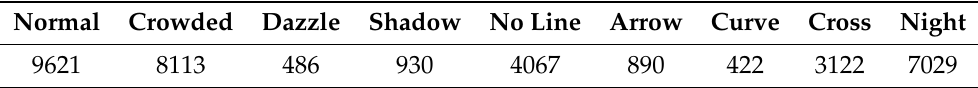
Table 9. The image number of different scenarios in CULane.